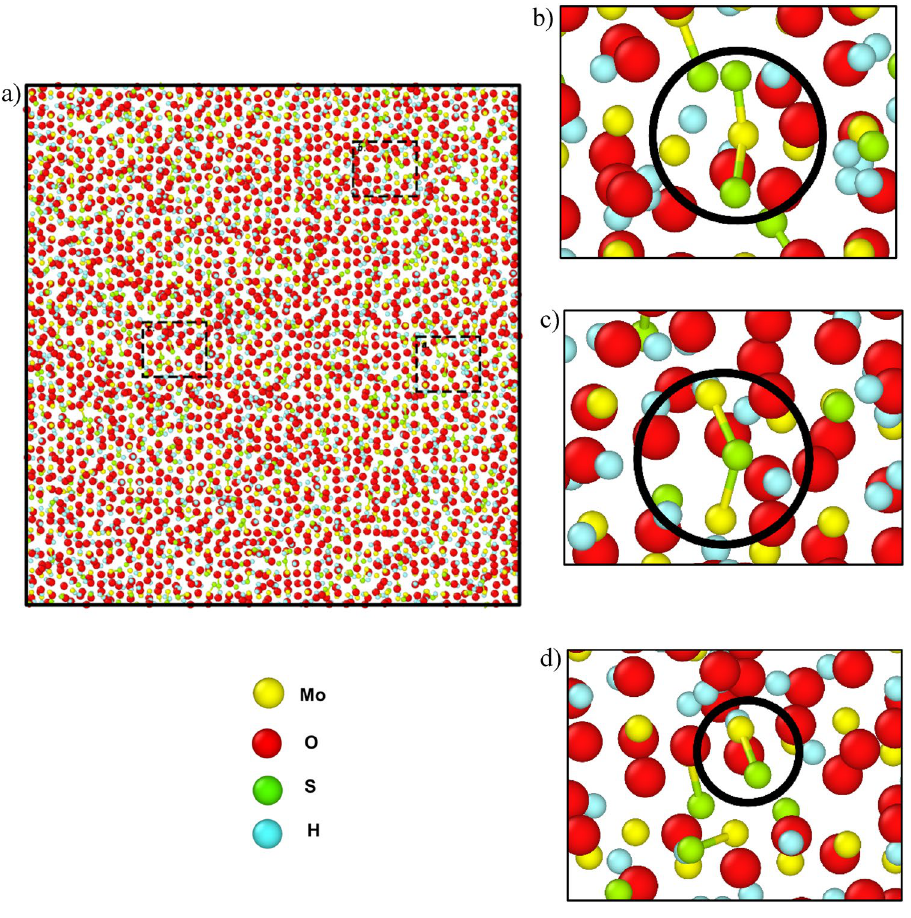
Figure 9. The surface composition due to the H 2 S precursor at 375 ps. ( a ) The formation of the MoO 1.72 S 0.33 H 1.37 surface showing the enlarged regions highlighting the ( b ) MoS 2, ( c ) (Mo) 2 S, and ( d ) MoS